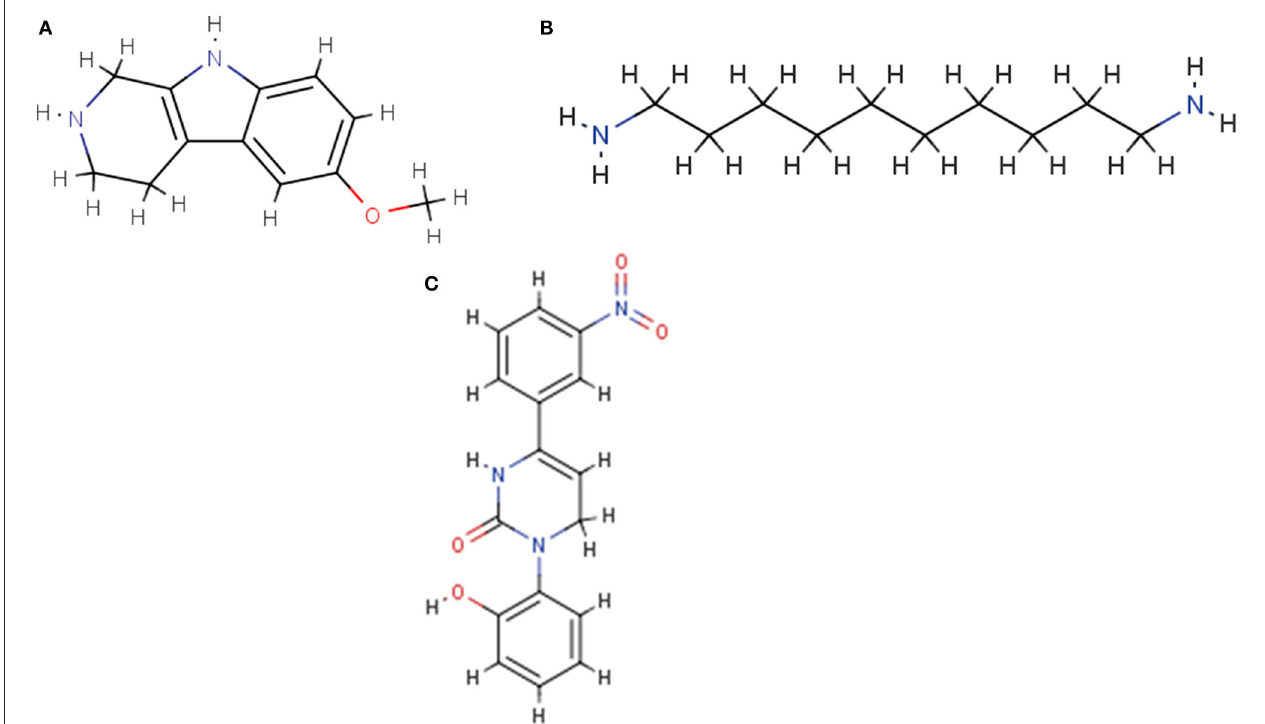
FIGURE 3 | Sample molecule structures displayed by the RDKit cheminformatics toolkit. (A) NCGC00260687. (B) NCGC00261143. (C) NCGC00261111.